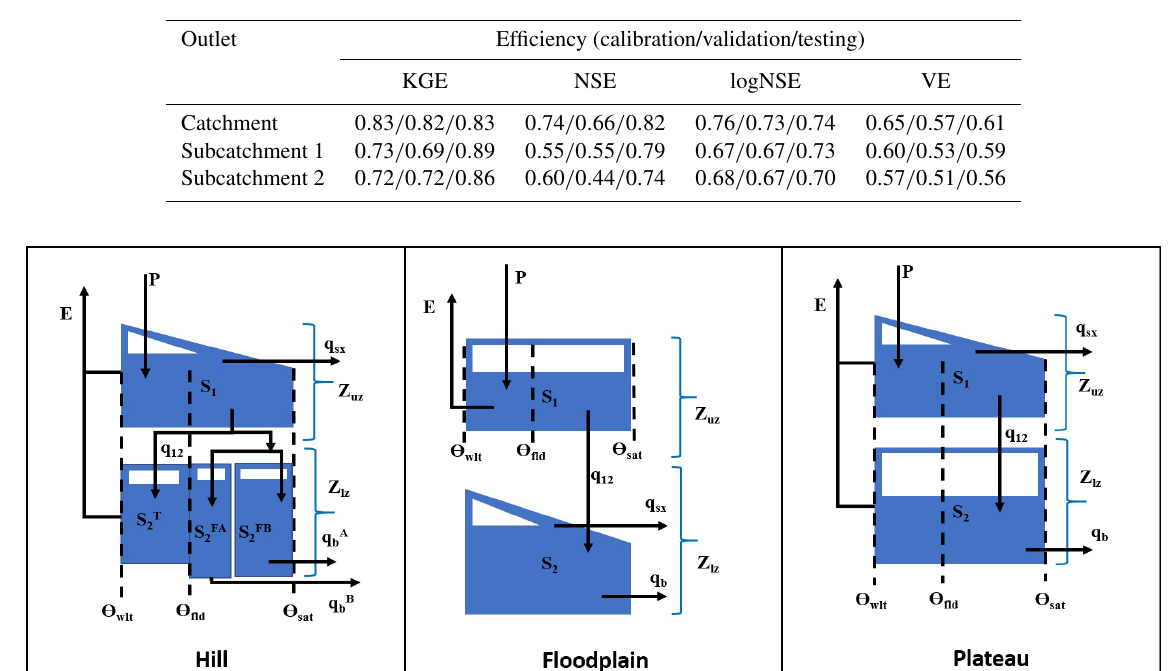
Figure 8. MIKA-SHA_FUSE model configuration ( P – precipitation; E – evaporation; q b – base flow; q s x – surface flow; q 12 – percolation; Z uz and Z lz – depth of unsaturated zone and saturated zone; S 1 and S 2 – unsaturated zone and saturated zone water content; S T water content; S FA and S FB : free water content in the primary and secondary baseflow storages; q A 2 2 secondary baseflow storages; (cid:50) wlt , (cid:50) fld , and (cid:50) sat – soil moisture at wilting point, field capacity, and